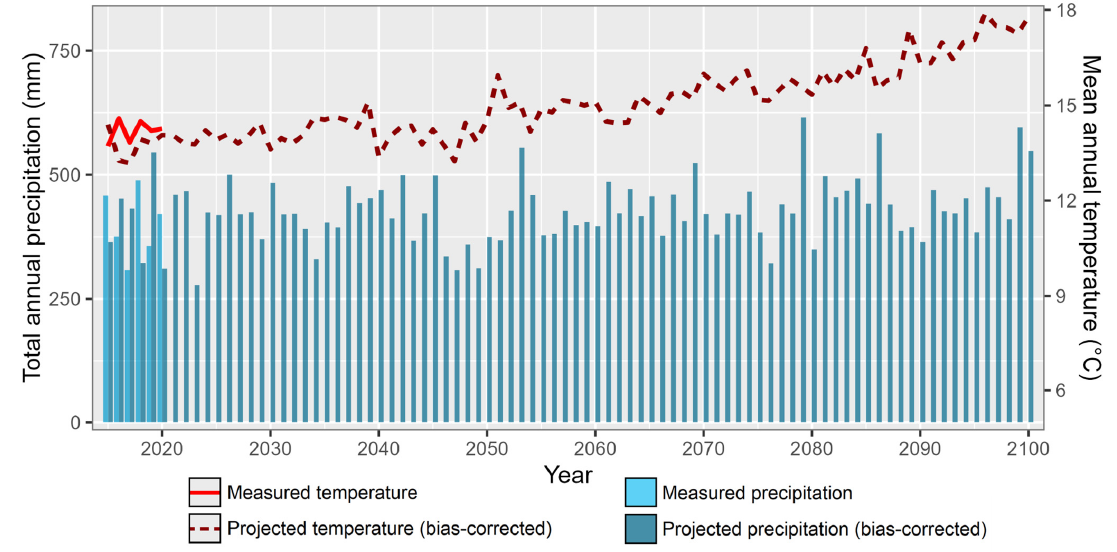
Figure 8. Annual mean air temperature and annual total precipitation values for validation (2015– 2020) and future prediction (2021–2100) periods.